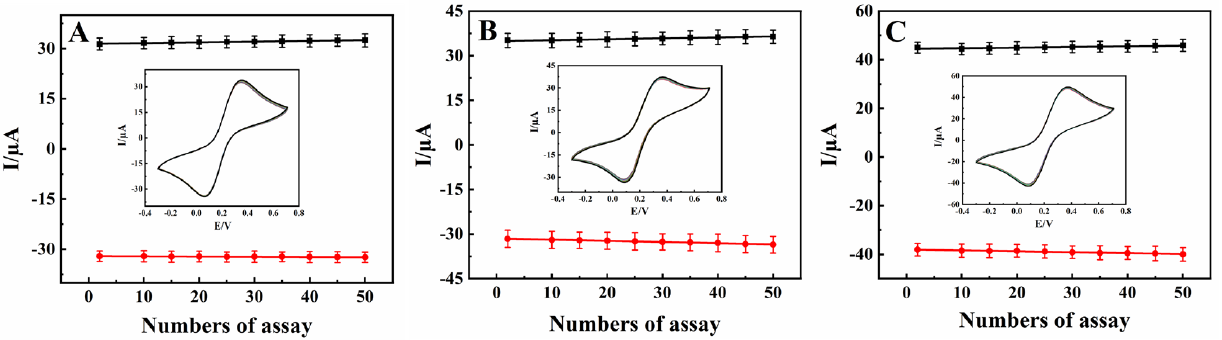
Figure 8. Stability of different electrodes with successive CV scans of ( A ) ND/SPE, ( B ) BP/SPE, and ( C ) ND@BP/SPE (n = 3). (Inset: Multi − scan CV curves of ( A ) ND/SPE, ( B ) BP/SPE, and ( C ) ND@BP/SPE in 1.0 mmol/L K 3 [Fe(CN) 6 ] and 0.5 mol/L KCl mixture at a scan rate of 100 mV/s.).